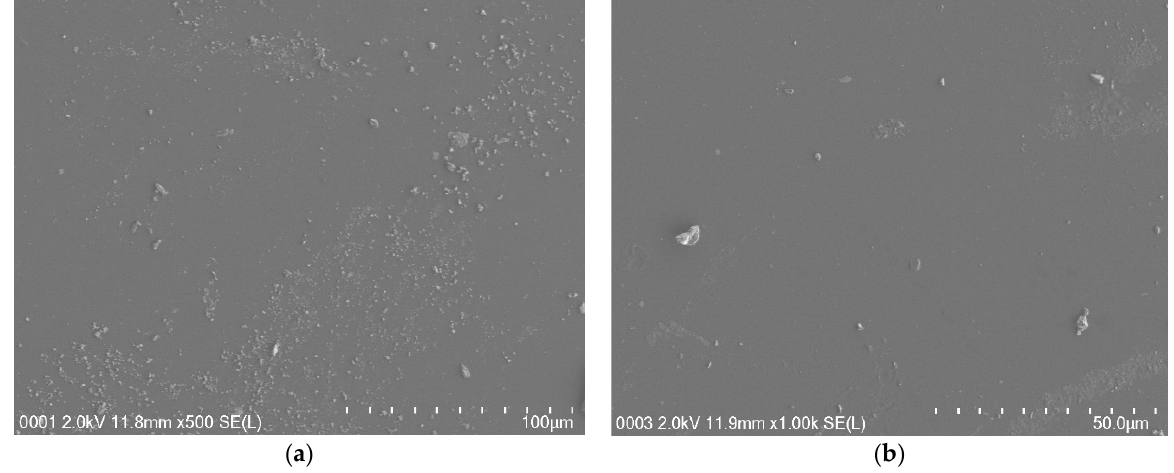
Figure 4. FESEM for ( a ) PSP_1 and ( b ) PSP_2 electrolyte systems at RT.